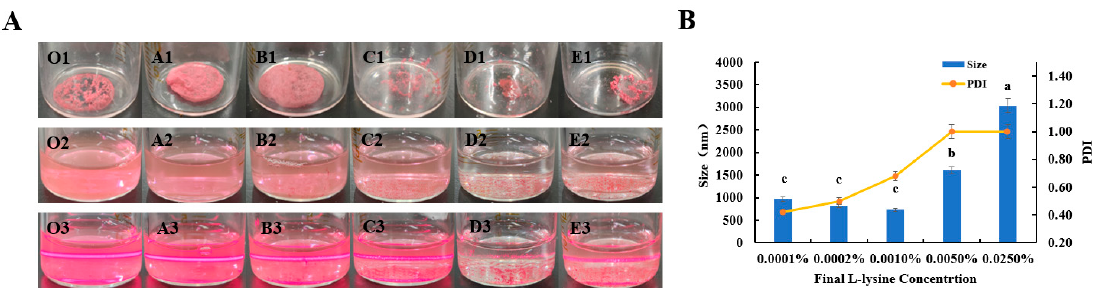
Figure 5. Effect of different concentrations of lysine on ABC-NPs lyophilized powder: the appearance of ABC-NPs (lyophilized powder, re-soluble state, and Tyndall effect) ( A ) and particle size ( B ). It can be seen from Figure 5B that the particle size decreases and the PDI increase with increasing concentration for the samples with L-lysine concentrations of 0.0001%, 0.0002%, and 0.001%. However, the particle size and PDI increased substantially after the L-lysine concentration reached 0.005%. The minimum Sa/Sb was only 2.24, and the maximum was 11.6, with a negative